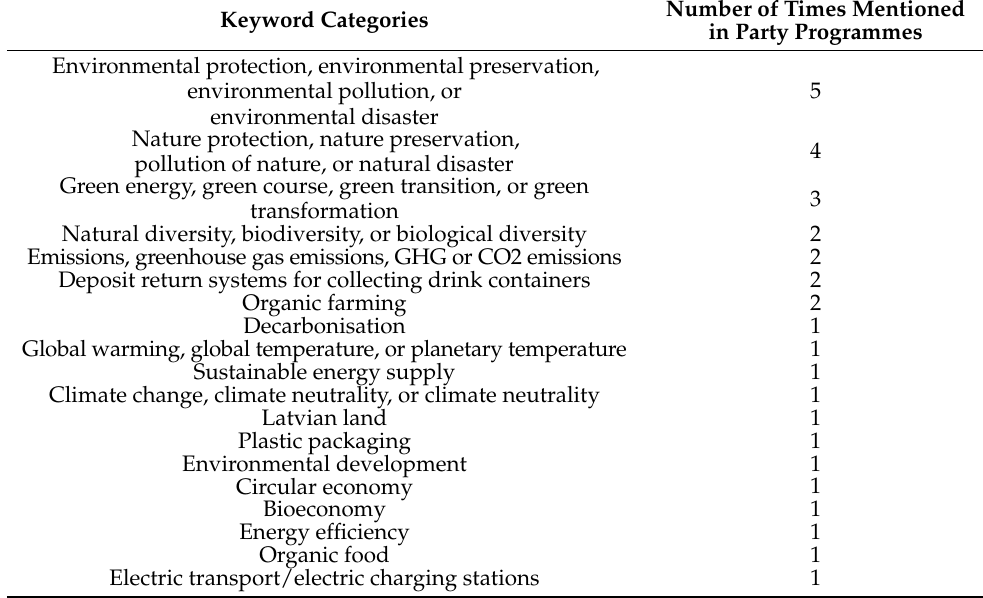
Table 6. Keywords most frequently mentioned in the context of climate change in the party